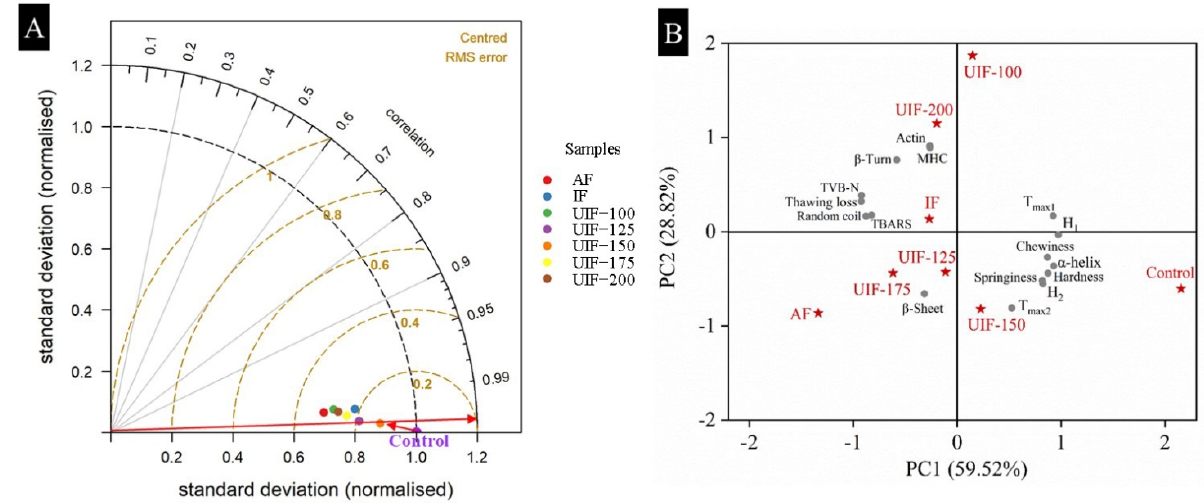
Figure 6. ( A ) Taylor diagram and ( B ) the principal component analysis (PCA) bi-plot of control AMS and 90-day frozen stored AMS with different treatments. AF, air freezing; IF, immersion freezing; UIF, ultrasound-assisted immersion freezing at different ultrasound powers (100, 125, 150, 175, and 200 W).